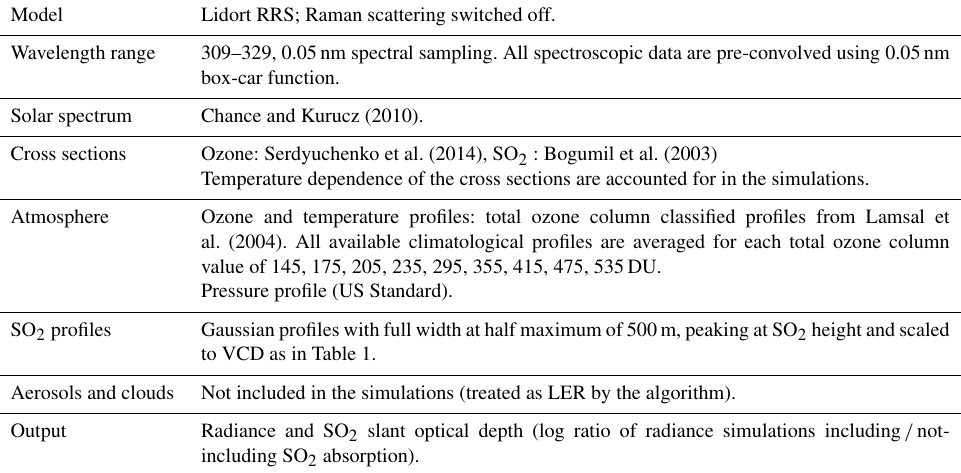
Table A1. Input settings used to generate radiative transfer simulation. Model Lidort RRS; Raman scattering switched